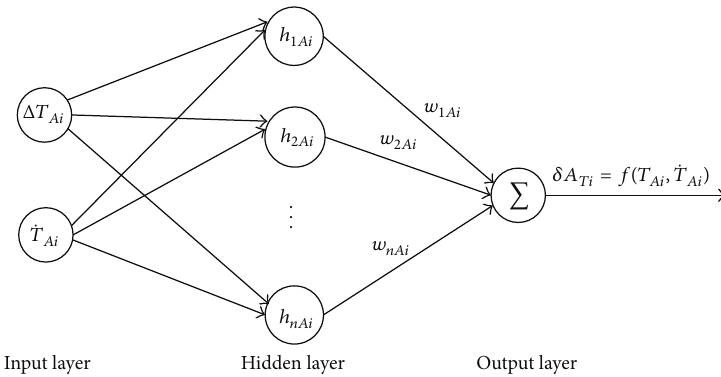
Figure 3: Temperature error modeling for accelerometer assembly based on RBF neural